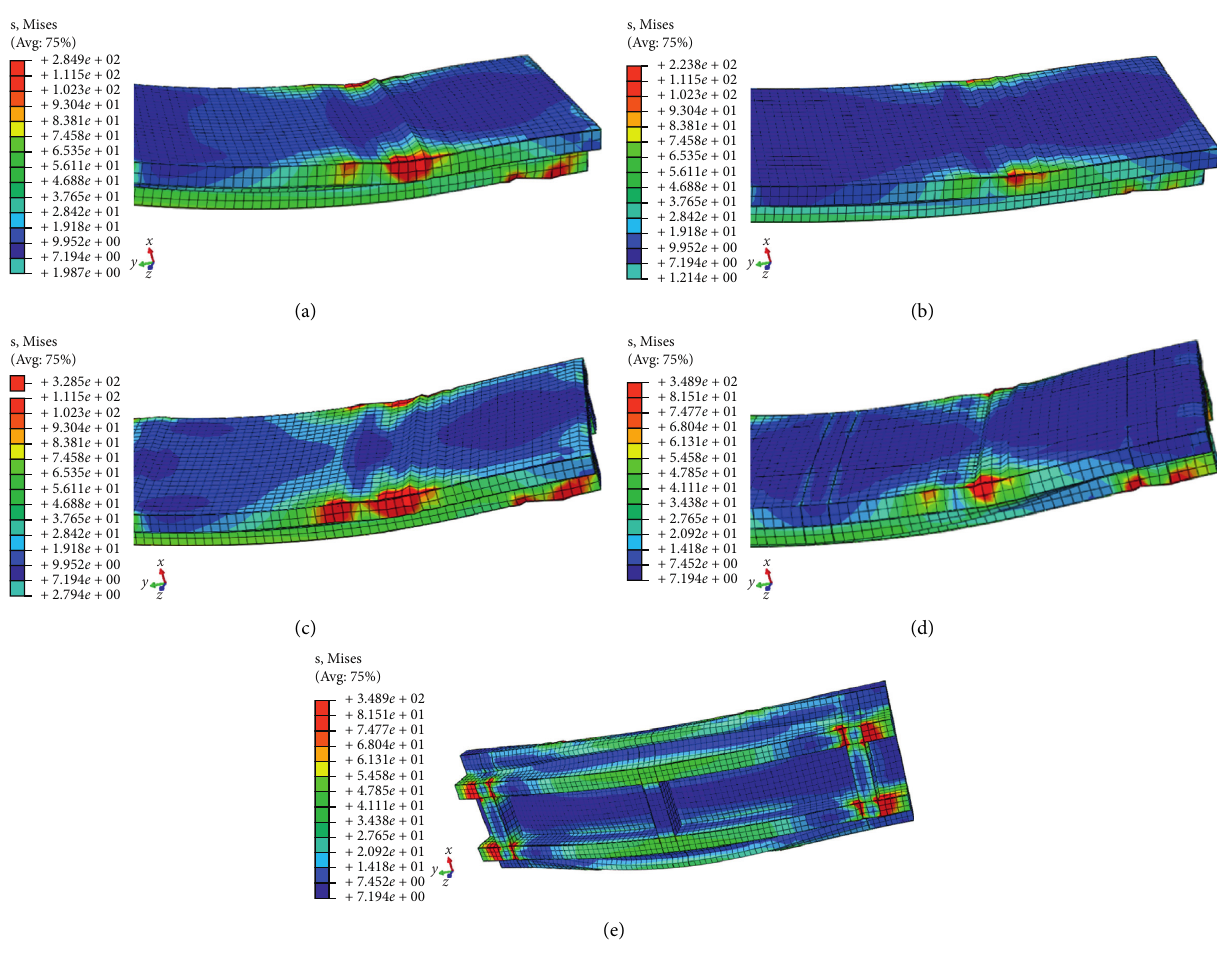
Figure 8: Simulated Mises stress contour at failure (unit: MPa): (a) S4D; (b) S4DV; (c) S4DT3 (top surface); (d) S4DT3 (bottom